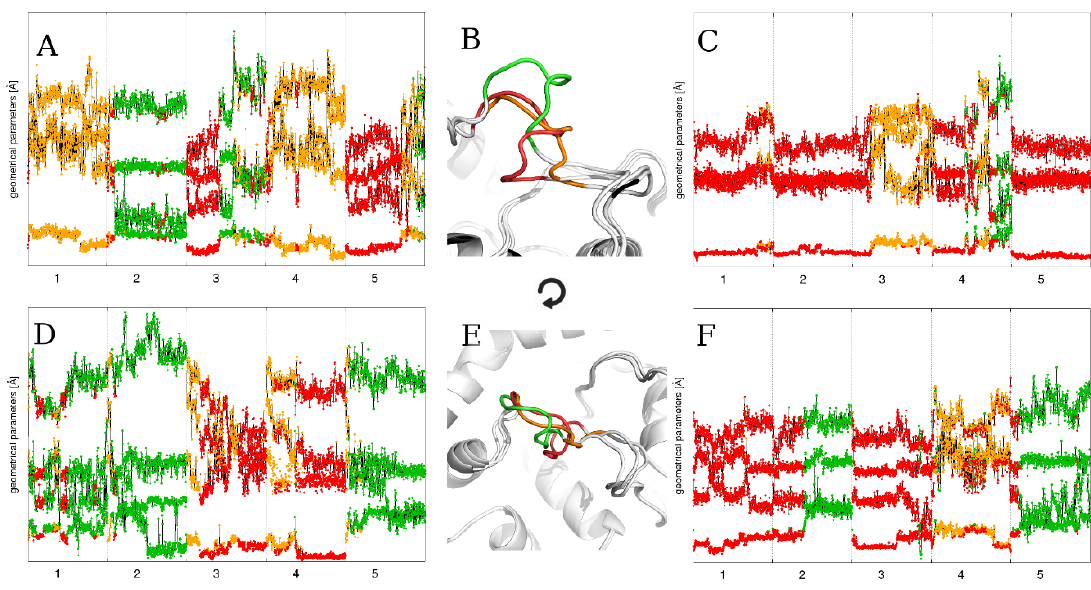
Figure 6. The time evolution of the four statistically significant loop parameters during five 500 ns MD runs using particular flexible loop models as a starting point: ( A ) FL_m1, ( C ) FL_m2, ( D ) FL_m3, and ( F ) FL_mDOPE, and ( B ) averaged loop structures in identified conformations: “open” (green), “semi-open” (orange), and “closed” (red), and ( E ) top view. The numbers on the horizontal axes represent the simulation repetition. Please note the colored points representing each loop conformational state and how the loop changes its conformation depending on the loop model used as a starting point. The loop structures representing each state are close to those from a similar analysis for 100 ns MD runs.